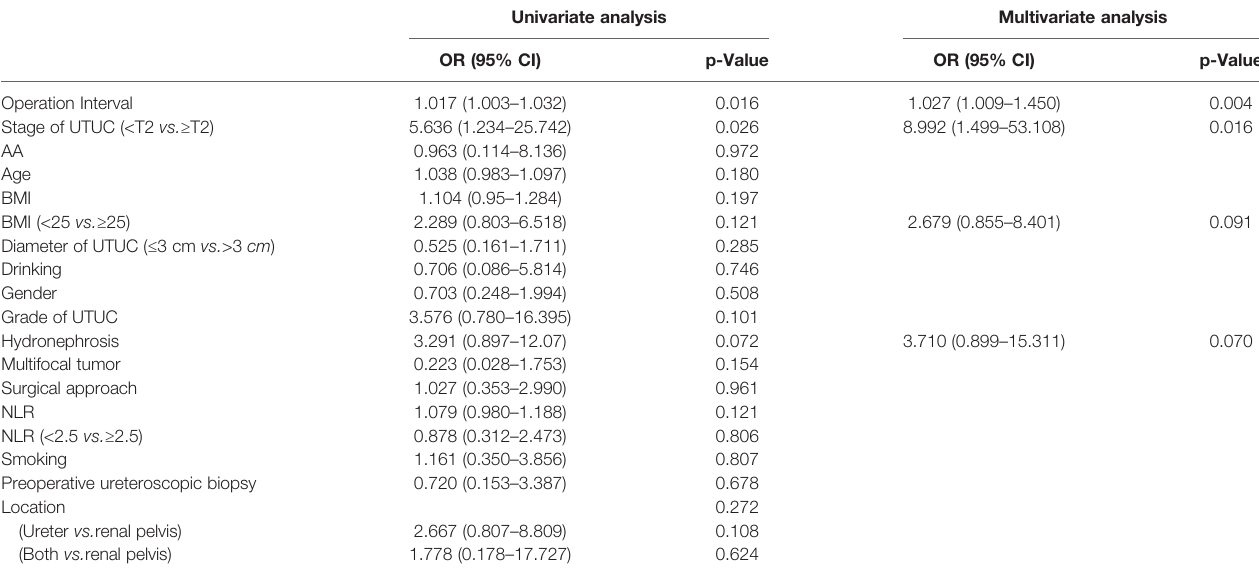
TABLE 2 | Univariate and multivariate analyses for factors associated with MIBC after